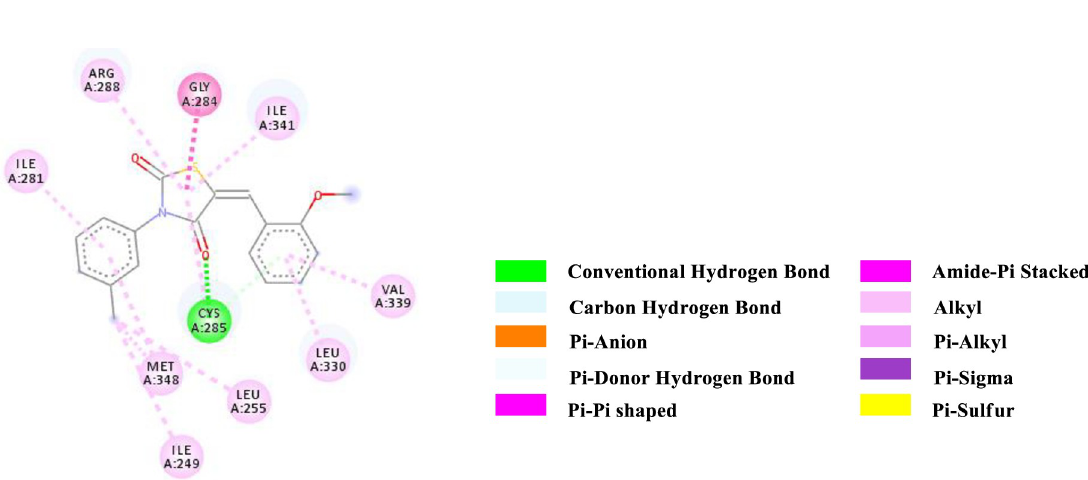
Fig 5. 2D-representation of the non-covalent interactions of 7a with receptor (3gbk) after flexible docking.